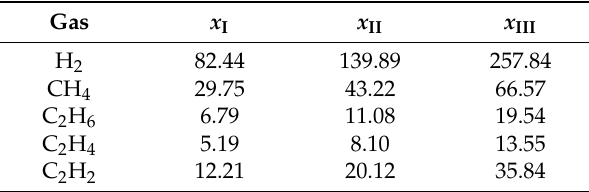
Table 3. The discrete intervals of the gas (uL/L).